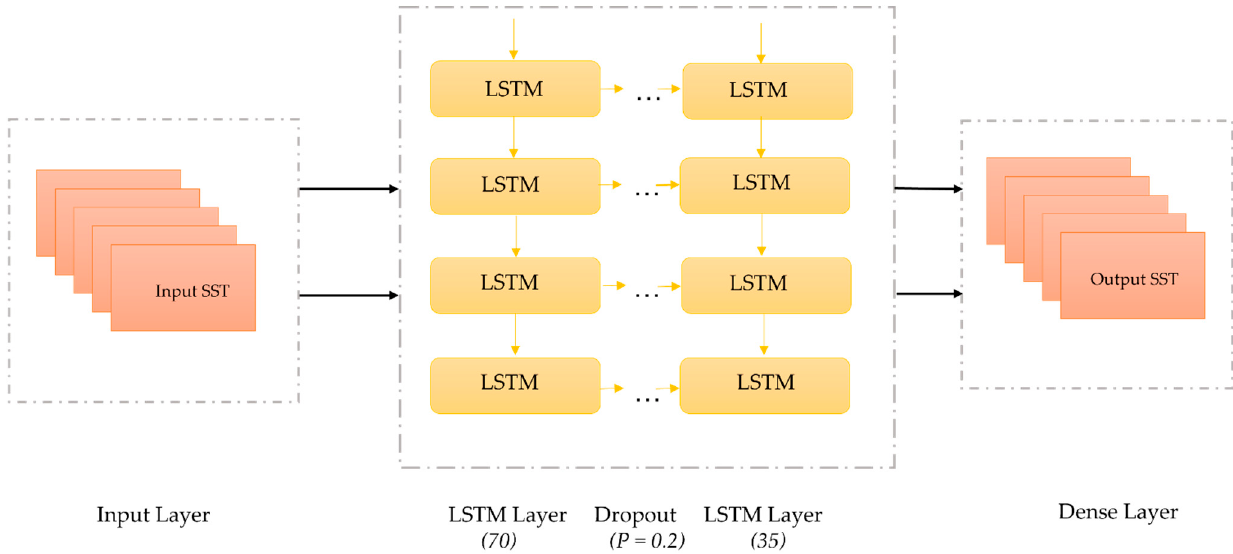
Figure 2. The architecture of the proposed LSTM deep neural network for SST prediction.